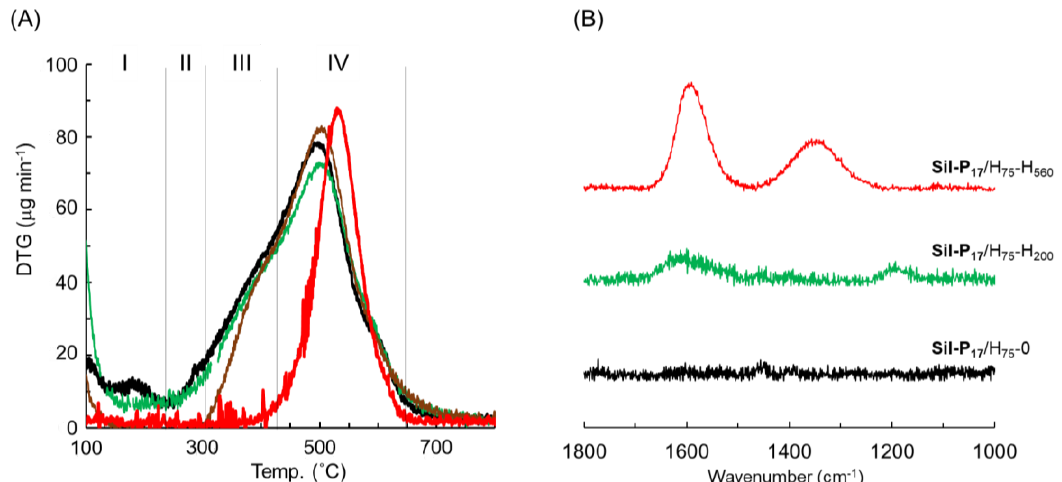
Figure 5. Characterization of the heat-treated Sil-P 17 . ( A ) Derivative thermogravimetric profiles of Sil-P 17 /H 75 -0 ( –– ), Sil-P 17 /H 75 -H 200 ( –– ), Sil-P 17 /H 75 -H 400 ( –– ), and Sil-P 17 /H 75 -H 560 ( –– ) in air. ( B ) Raman spectra of Sil-P 17 /H 75 -0 ( –– ), Sil-P 17 /H 75 -H 200 ( –– ), and Sil-P 17 /H 75 -H 560 ( –– ).